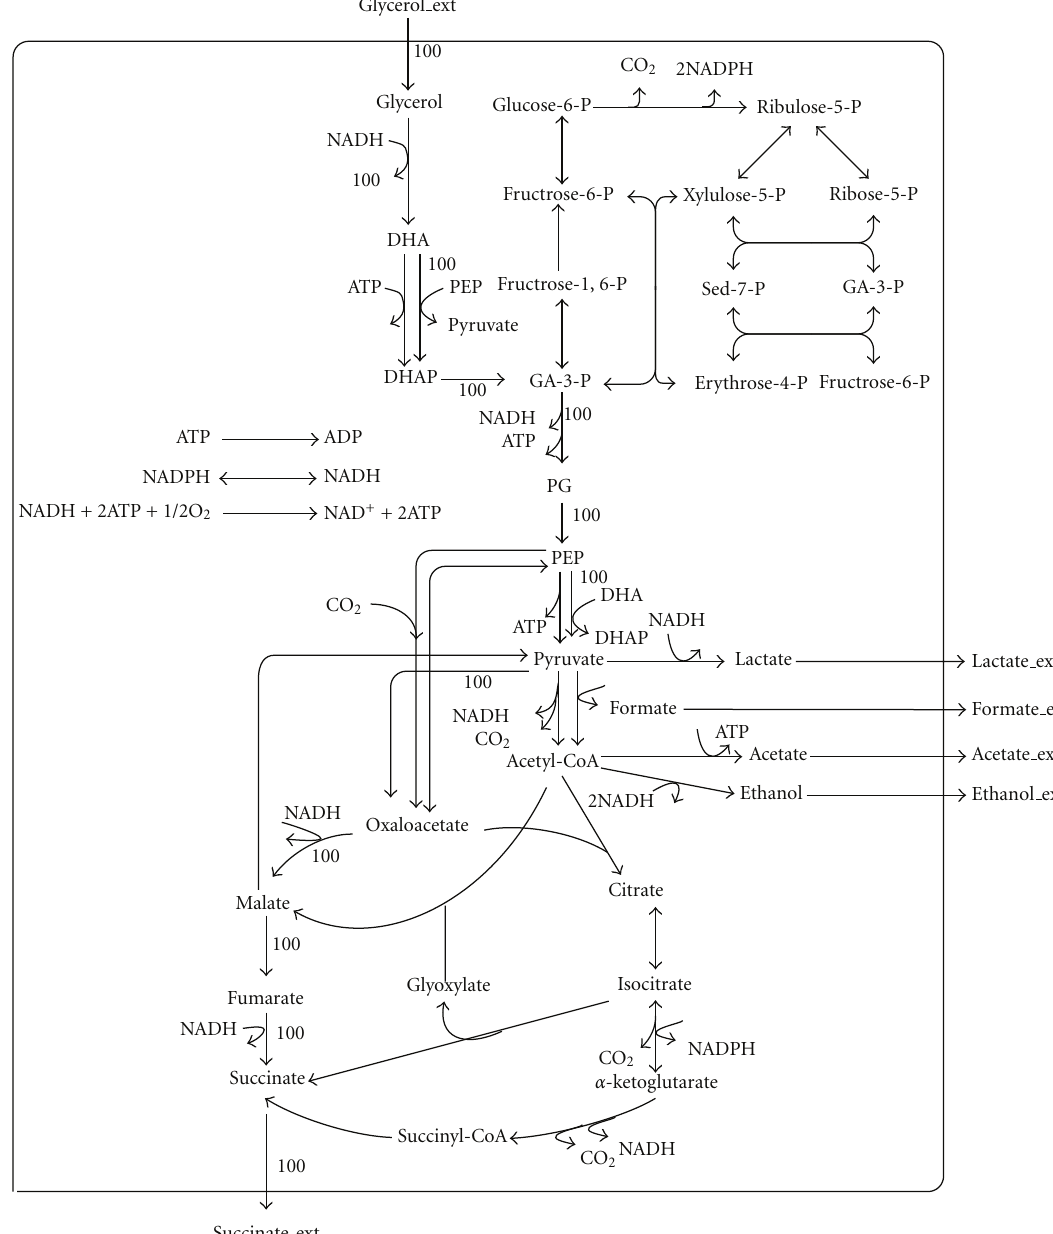
Figure 4: The alternative optimum flux distribution of glycerol metabolism for succinate production in E. coli under anaerobic conditions when only PEP-dependent DHA kinase plays a function and heterogeneous PEP carboxylase (pyc) are introduced and overexpressed in E. coli